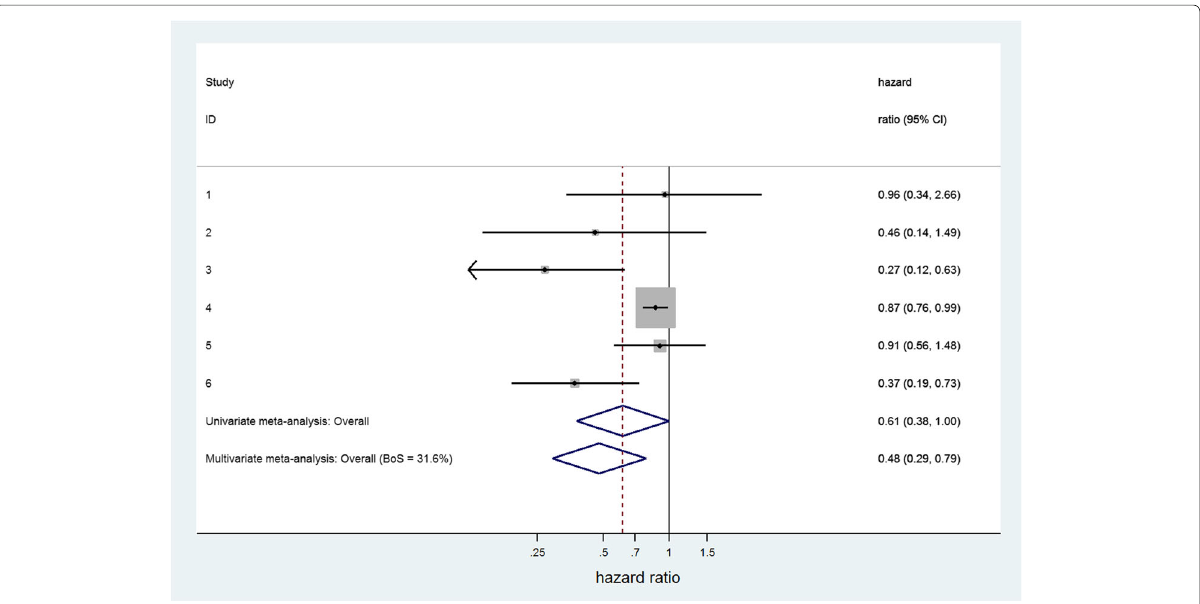
Fig. 1 Forest plot for prognostic effect of progesterone on cancer specific survival in endometrial cancer, with summary results for univariate and multivariate meta-analysis. The multivariate meta-analysis of cancer specific survival and progression-free survival used the approach of Riley et al. to handle missing within study correlations, through restricted maximum likelihood estimation [33]. Heterogeneity was similar in both univariate and multivariate meta-analyses ( I 2 =